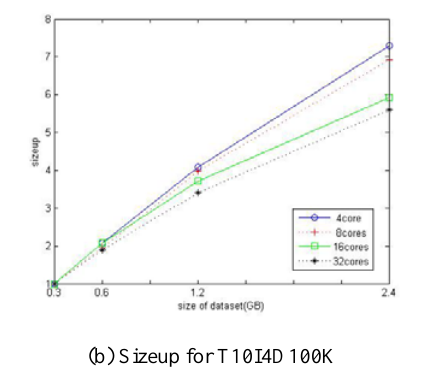
Figure5. Sizeup performance evaluation